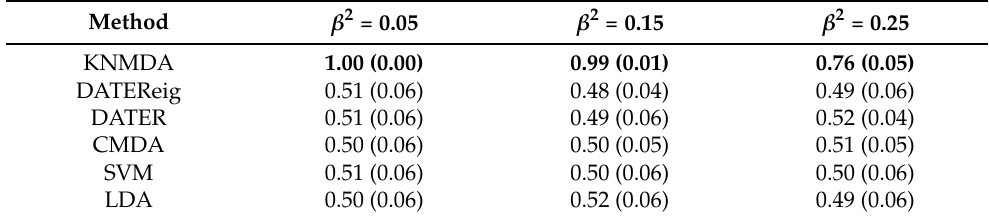
Table 4. Classification of Sparsity Patterns. The bold values represent the best performance for each column.